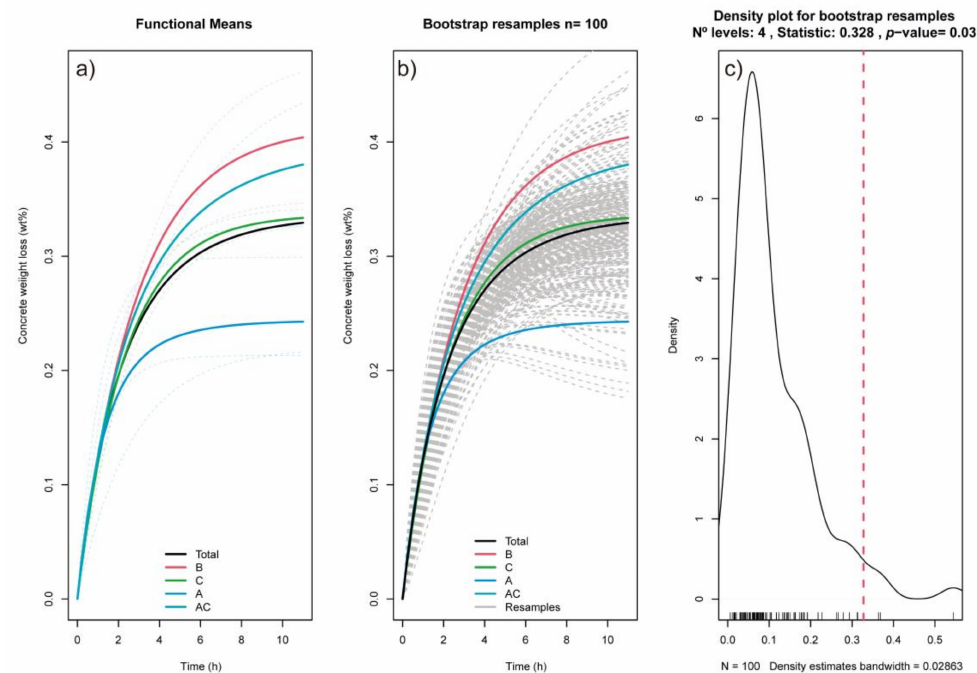
Figure 15. Results of the application of FANOVA test. ( a ) Functional means for the degradation paths corresponding to each concrete formulation. ( b ) Functional means in addition to all the degradation curves obtained by bootstrap resampling (100 resamples). ( c ) Estimates of the density function of the test statistic, value of the sample statistic (in red), and corresponding p -value. The A formulation is the treatment where the 20 wt.% is replaced by mussel shells, the B level is the control treatment, in the C treatment, the 10 wt.% of cement has been replaced, whereas in the AC treatment, we replace the 10 wt.% of sand and the 5 wt.% of cement by